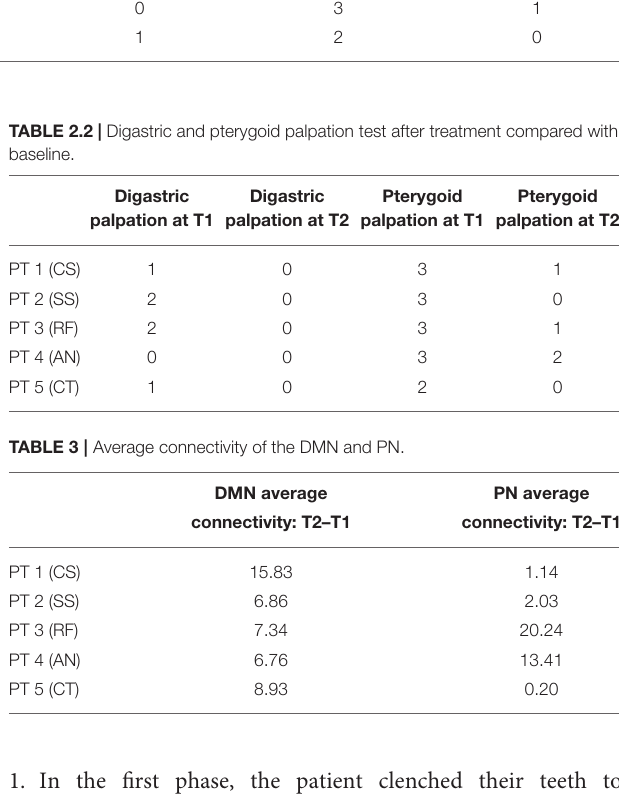
Sternocleidomastoid palpation at T2